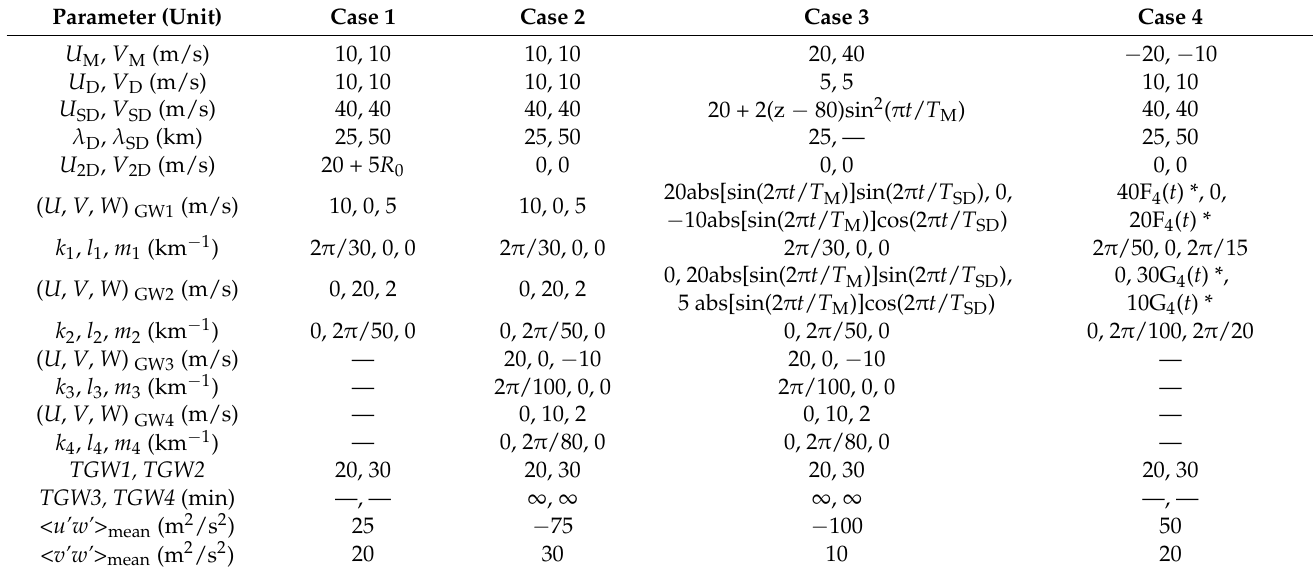
Table 1. Parameters of the specified winds including the mean wind, tides, PWs, and GWs.